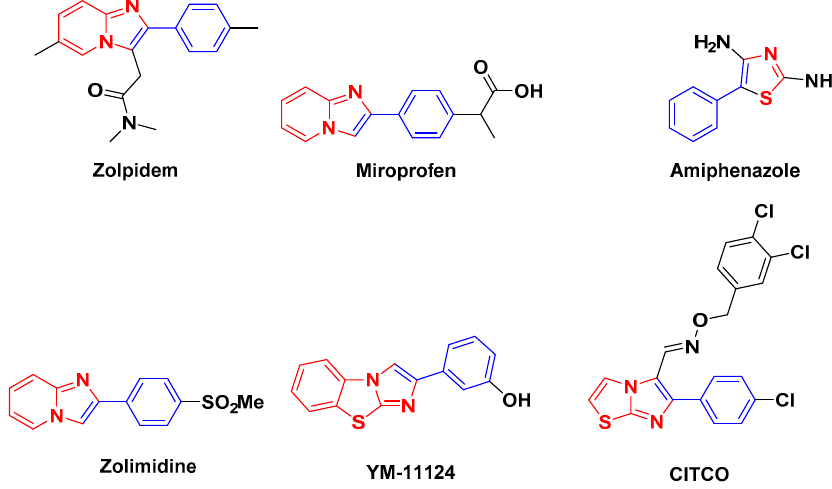
Figure 1. Biologically active compounds based on imidazoles and thiazoles.